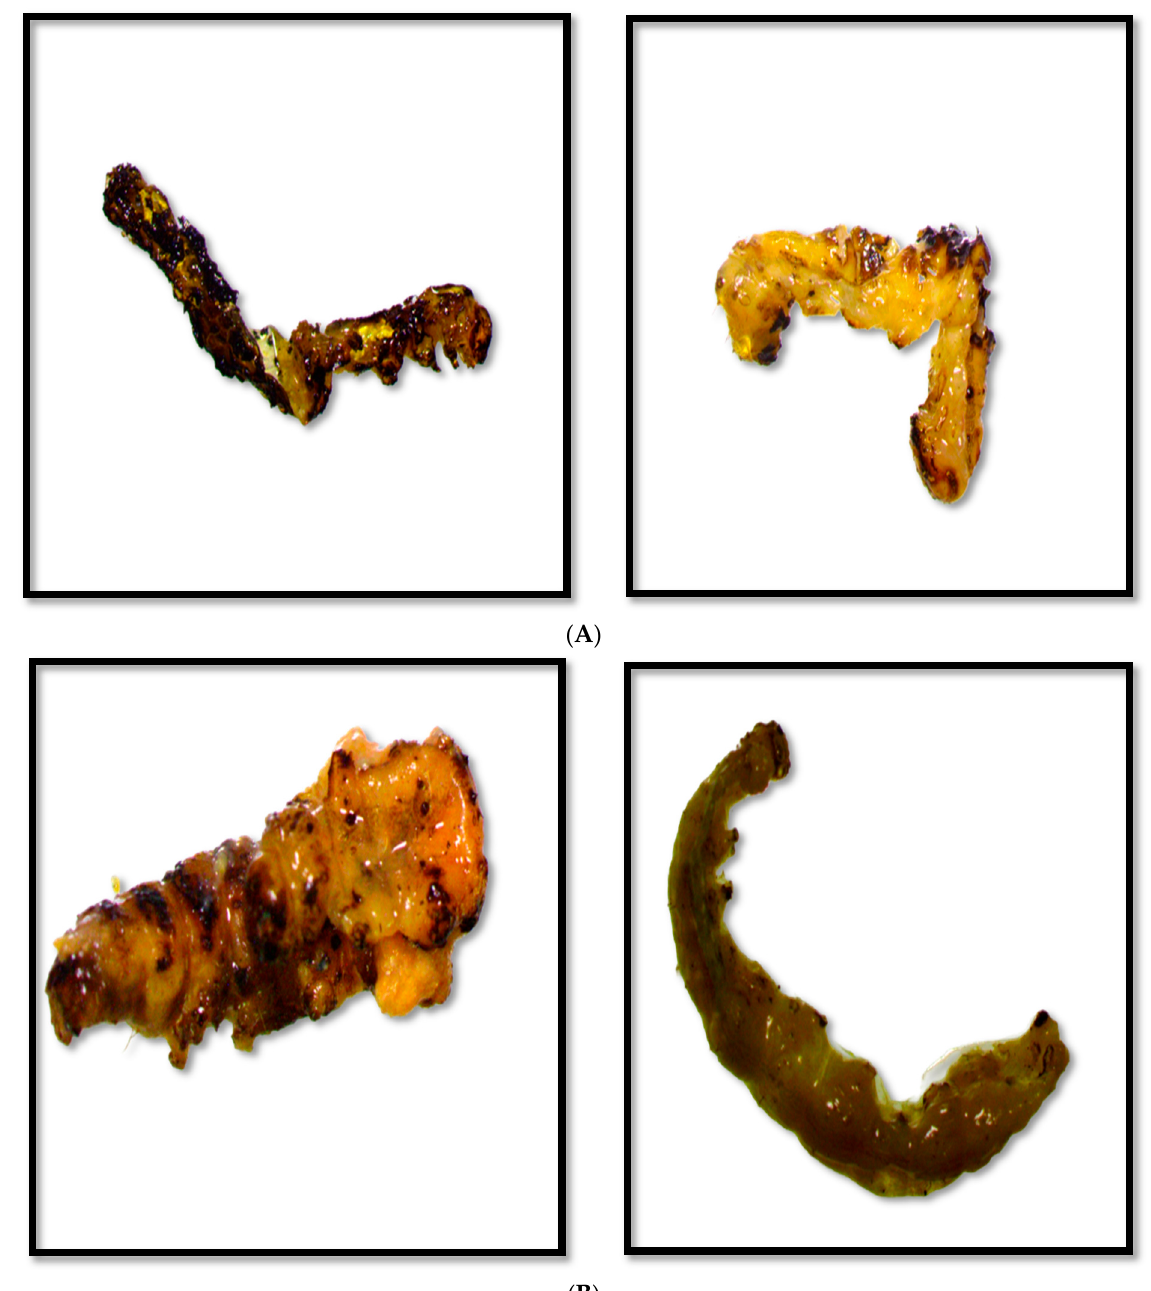
Figure 5. ( A ) Toxicity of Azadirachta indica -based AgNPs on 2nd instar larva of Helicoverpa armigera . ( B ) Toxicity of Pongamia pinnata based AgNPs on 2nd instar larva of Helicoverpa armigera . The highest larval mortality of 93.33 percent was registered at 2000 ppm of A.